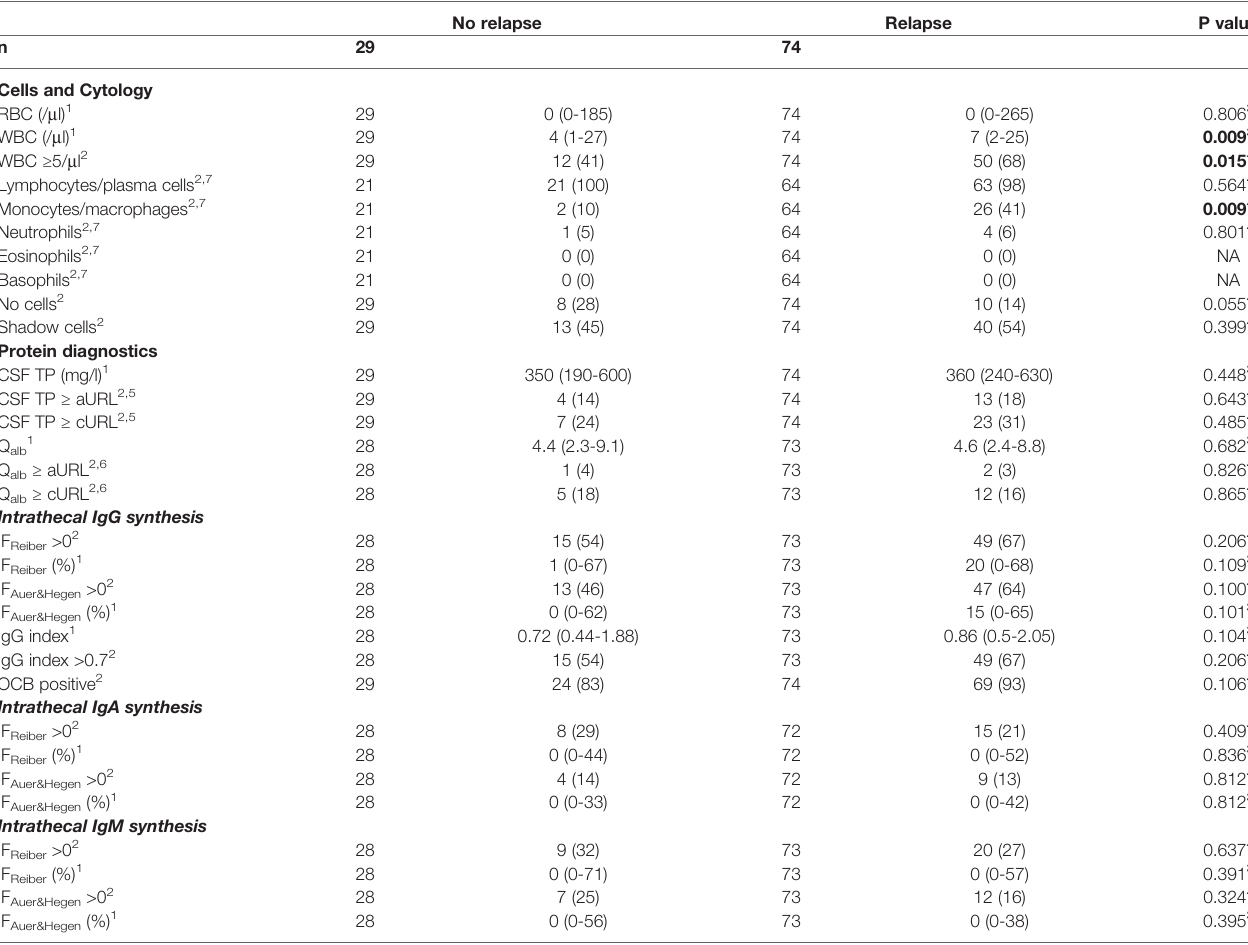
TABLE 2 | Cerebrospinal fl uid fi ndings in patients with a fi rst clinical attack according to the occurrence of a second relapse during